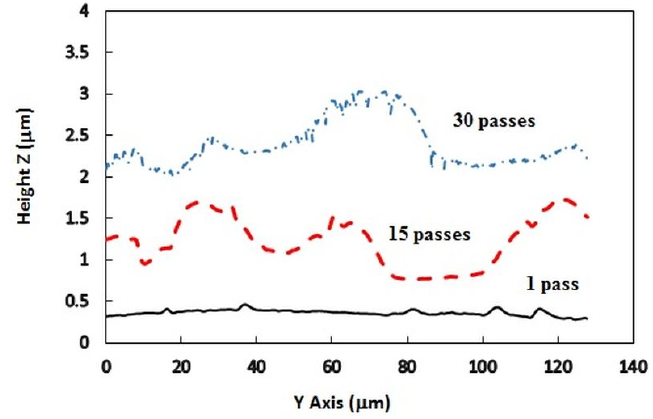
Figure 7. Effect of the number of spray passes on the film profile: Surface profiles of spray-on P3HT:PCBM films were obtained along an arbitrary line with a length of 130 μ m, as shown in Figure 4. Carrier air pressure is 0.2 MPa, flow rate is 1 mL/min, and concentration is 1.8 mg/mL. Note that the y -axis is to show the surface profiles only, and it cannot be used to estimate the film